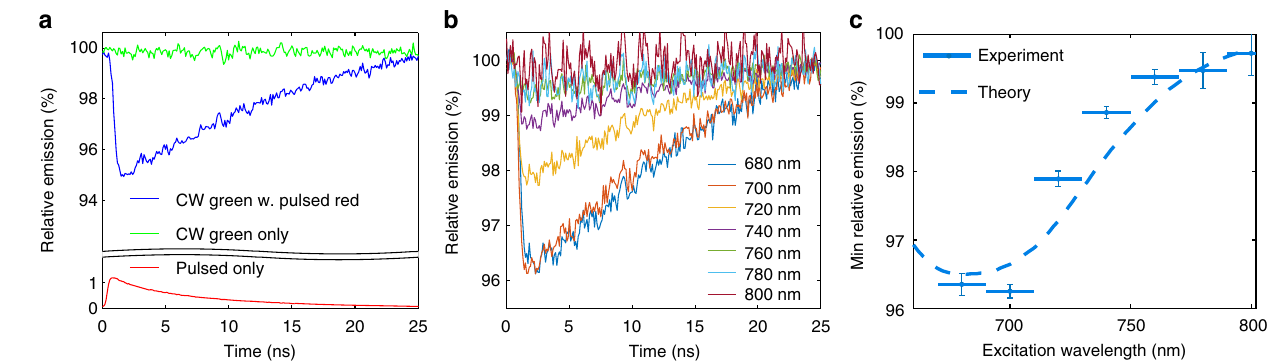
Figure 3 | Temporal emission reduction for different stimulating wavelengths. ( a ): raw data of temporally resolved emission which is spectrally integrated below 650nm. The fluorescence reduction occurs instantly at the point in time of the red pulse. Then the emission recovers in between pulses. ( b ) Temporal emission curves for different pulsed excitation wavelengths ( c ) The minimal relative emission directly after the pulse as a function of the pulsed excitation wavelength shows that the greatest reduction in emission occurs around 700nm corresponding to the peak of the phonon sideband of the NV. The error bars give the standard deviation of the temporal data points averaged for